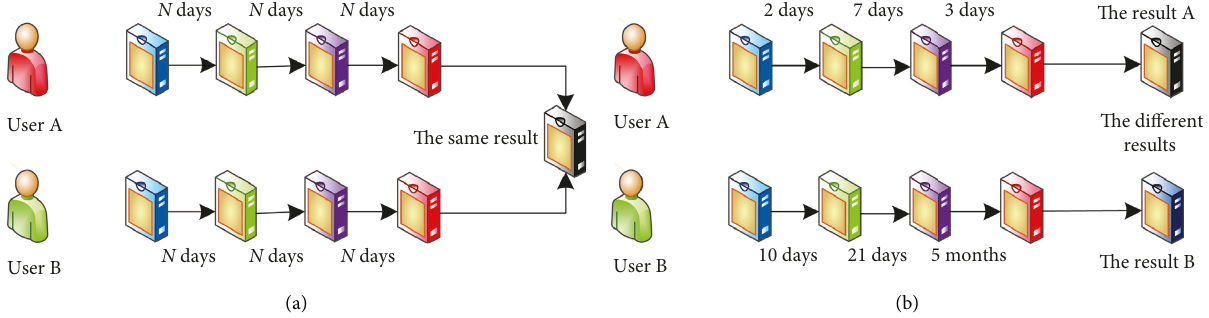
Figure 4: The effect of different time intervals on recommendation results. (a) Traditional sequential recommendation. (b) Our proposed